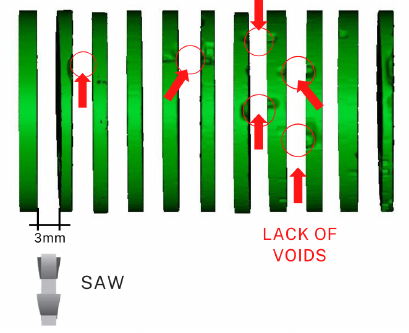
Figure 11. Visualization of the problem of the lack of modeled internal structure of